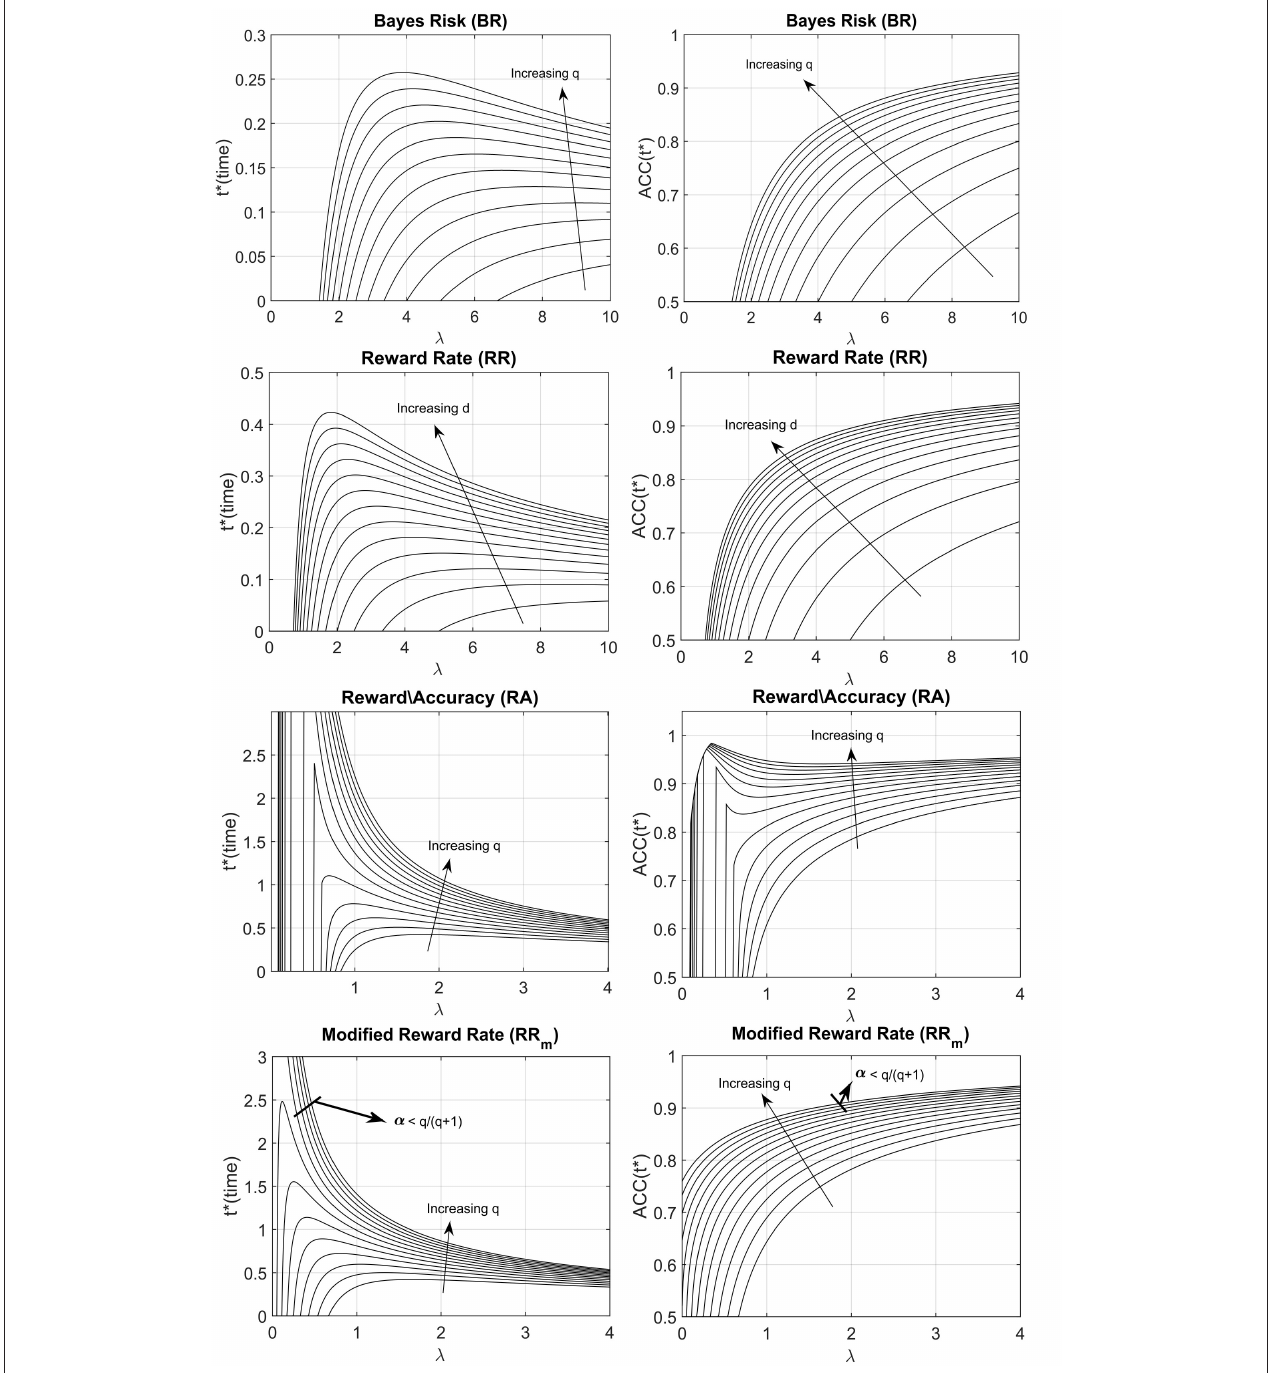
FIGURE 2 | Optimal response time, t * (left column) and ACC( t * ) (right column) vs. λ for the four decision rules, with different parameters q and d. ACC ( t *) indicates the optimum level of accuracy that has to be reached upon responding. The arrows indicate how the shape changes when the d or q parameter is increased. The q parameter represents the subjective punishment/reward ratio; the d parameter represents the length of the trial, excluding the reaction time. Increasing q or increasing d corresponds to an increase in the optimum response time ( t * ) and a consequent increase of ACC( t * ). For the Modified Reward Rate ( bottom panels ), two very different t * shapes are produced with different combinations of q and α (the starting point of the gauge).